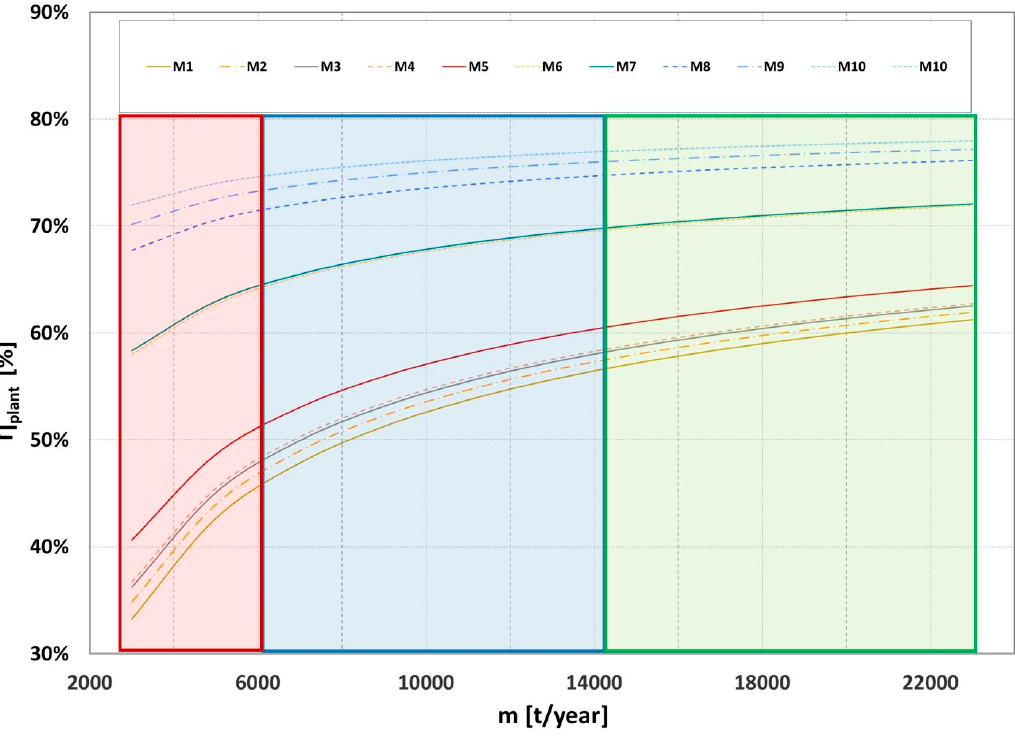
Figure 4. Conversion efficiency of biogas production plant with changes in yearly flow rate and substrate typology.